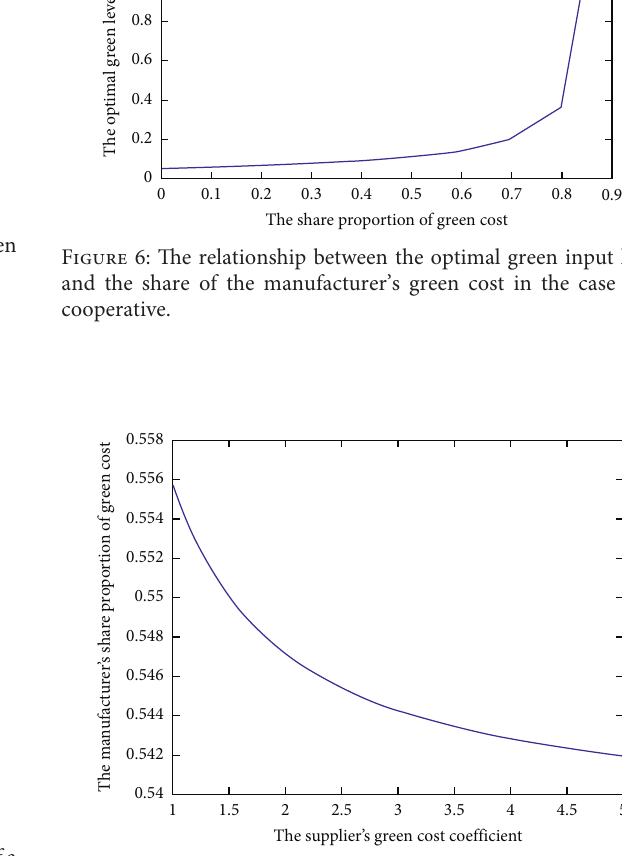
Figure 7: The relationship between the manufacturer’s share of green cost and the supplier’s green cost coefficient.